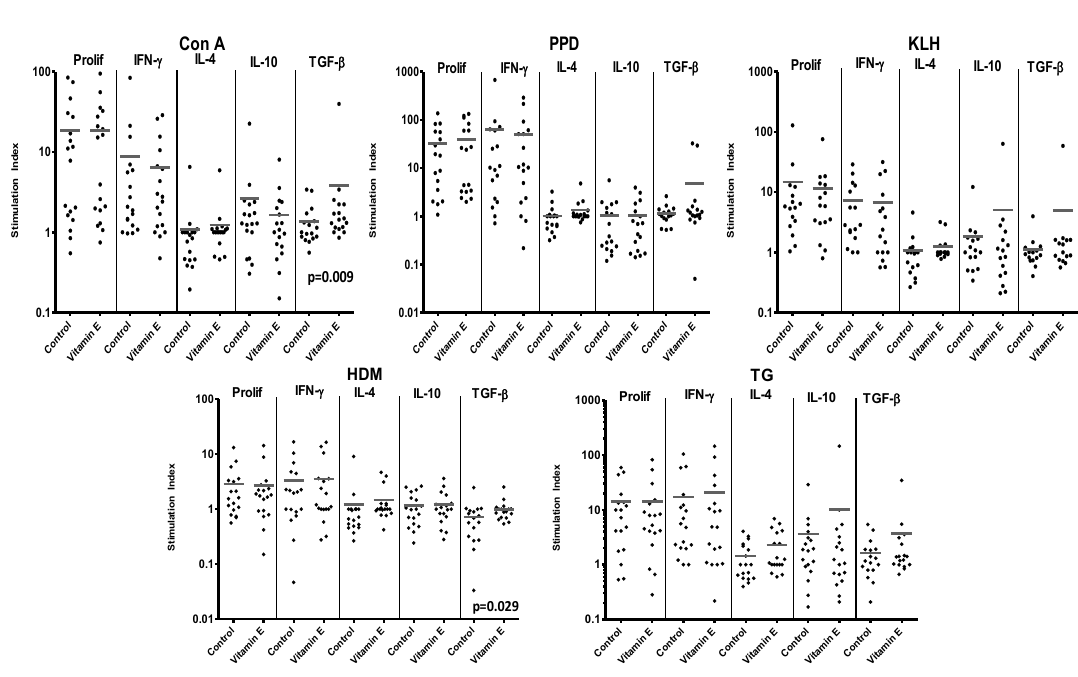
Figure 2. Responses of 18 PBMC samples to control stimuli and allergens, with or without supplementation with vitamin E. Reponses are expressed as stimulation index. Bars represent mean stimulation indices for each set of culture conditions. Significant p values for differences in responses between paired samples in cultures with or without vitamin E supplementation are shown on the relevant panels.